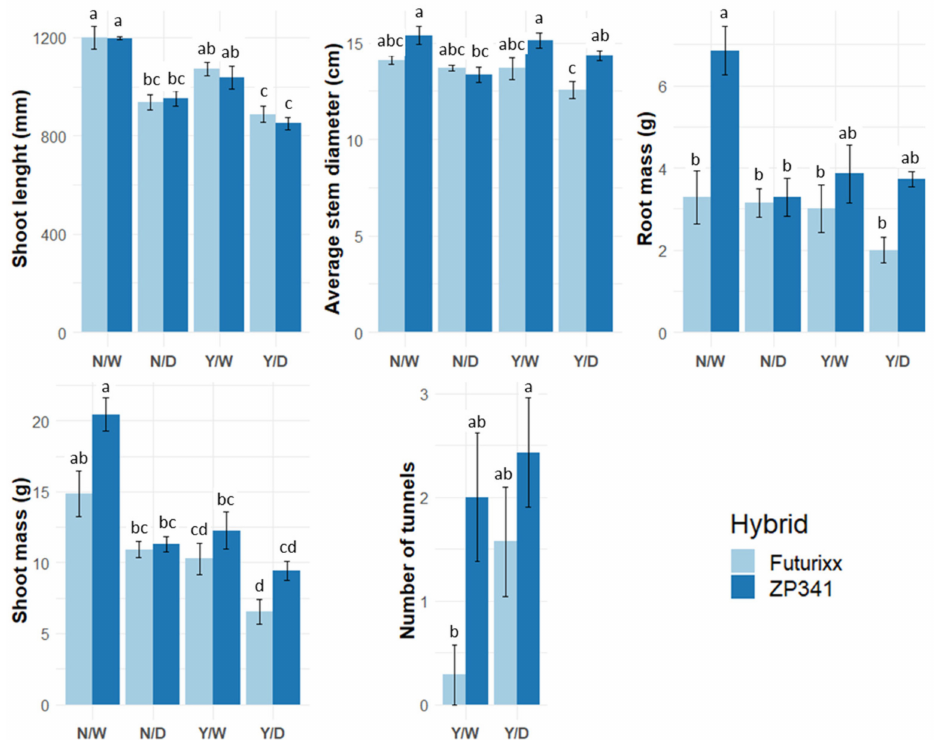
Figure 6. Morphological parameters of two maize hybrids subjected to herbivory (no wireworms (N) vs. wireworm-infested (Y)) and to two water regimes (well-watered (W) vs. water-deficient (D)). Data are presented as mean values ± SE (n = 7). Different letters indicate a significant difference between treatments ( p <